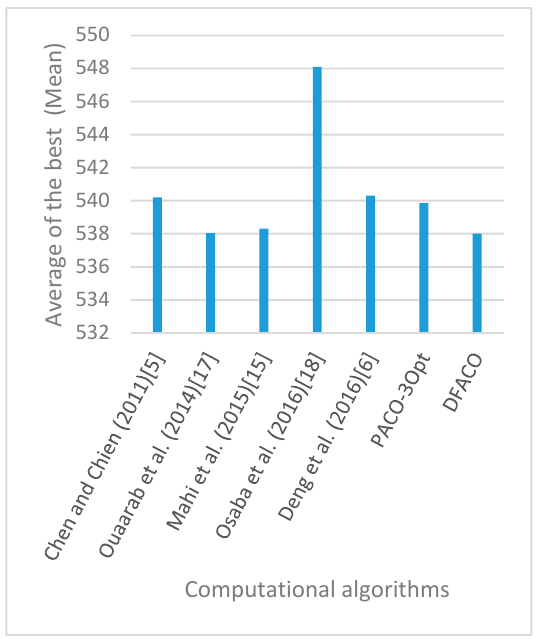
Figure 9. Average of best solutions obtained for instance eil76 by all algorithms.